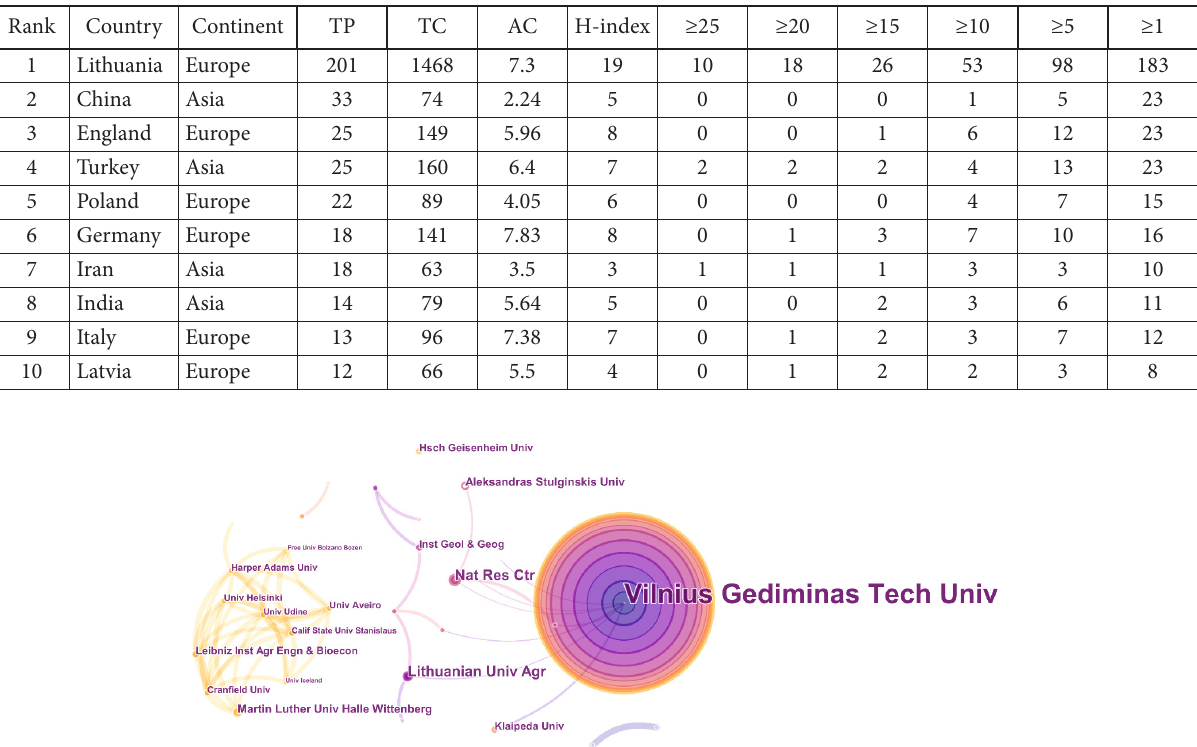
Table 4. The top 10 most influential countries of the JEELM publications